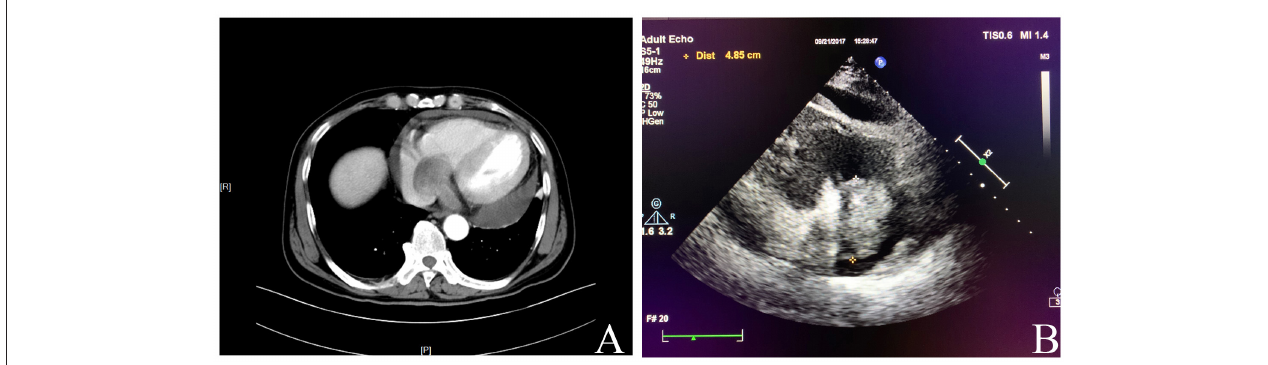
FIGURE 1 | (A) Computed tomography showed an occupying lesion involving the right atrium and the right ventricle. (B) Echocardiography revealed a mass in the right atrium with moderate pericardial